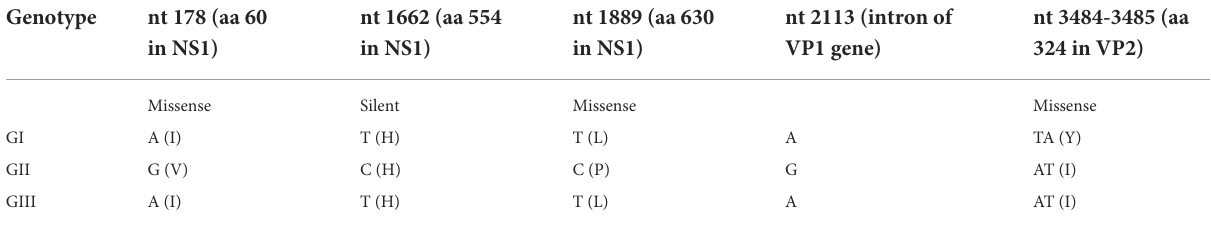
TABLE 3 Genetic signature of CPV-2 genotypes.